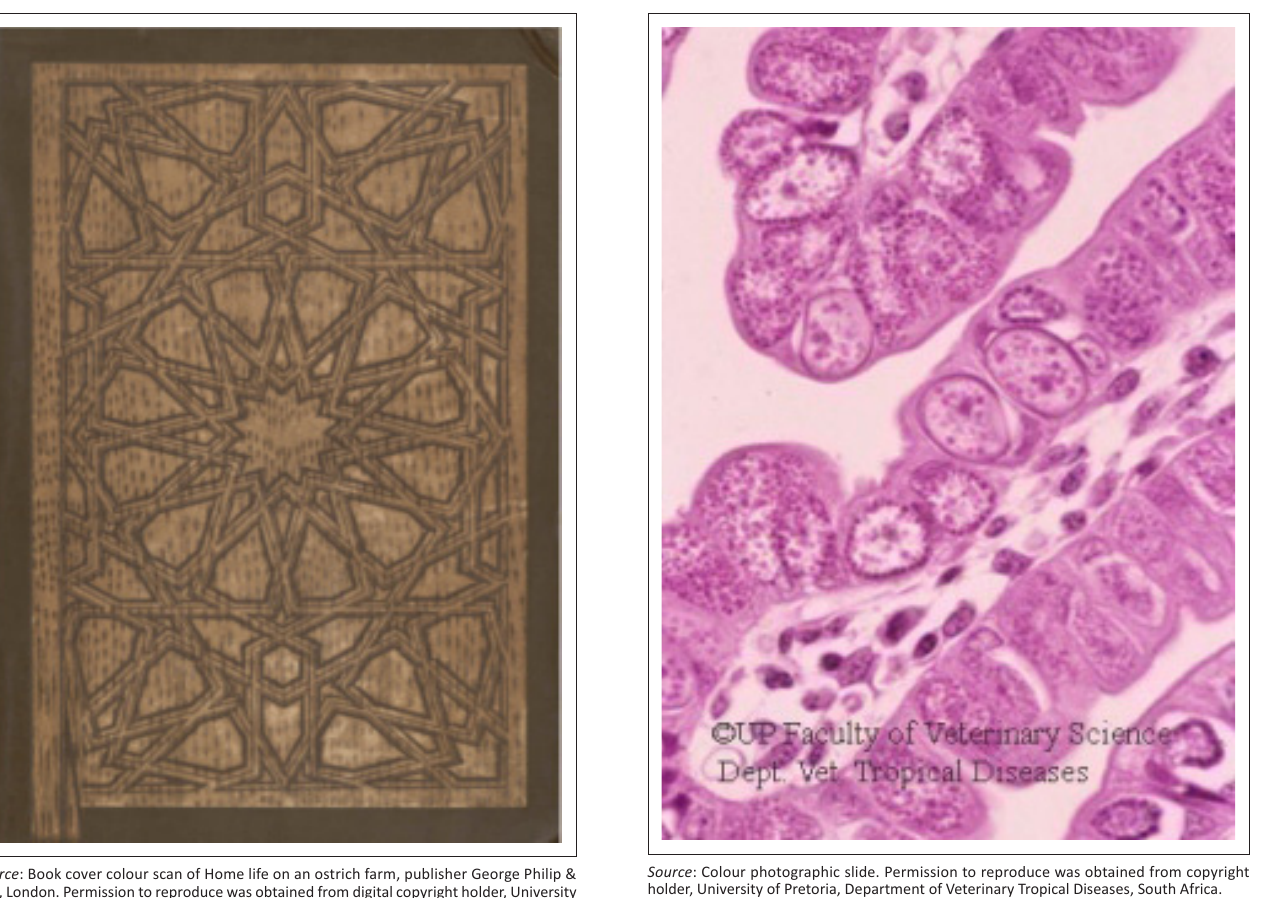
FIGURE 3: Various stages of the life cycle of an Eimeria sp. in intestinal epithelial cells. FIGURE 2: Book cover of Annie Martin’s 1890 book Home life on an ostrich farm